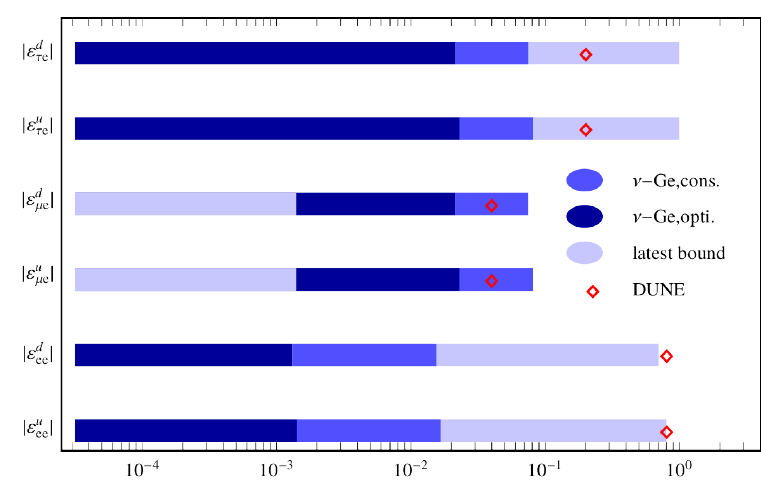
Figure 17.1: Future coherent bounds on NSIs, from Ref. [ 274 ]